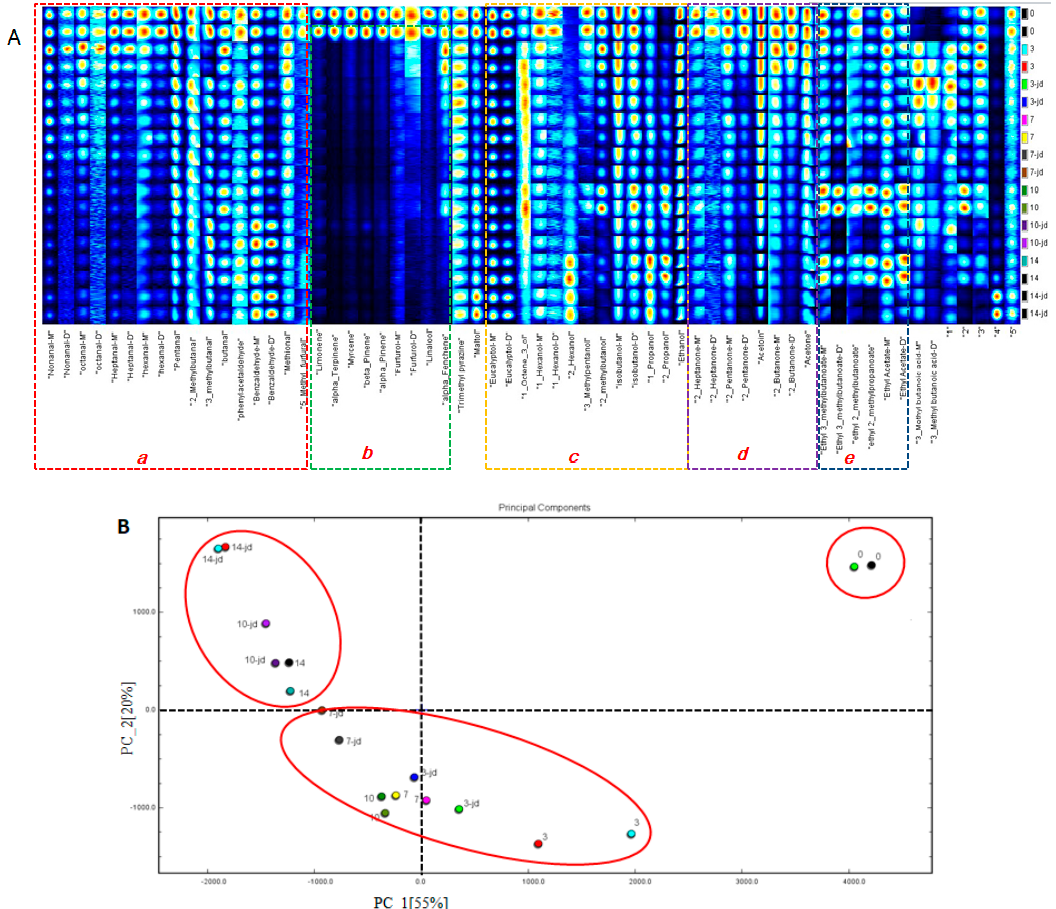
Figure 5. ( A ) The gallery plots of volatile compounds in dry-cured beef samples at 0, 3, 7, 10, and 14 days under di ff erent treatments. Each column represents the same substance in di ff erent samples, and each row represents a sample. a, red frame; b, green frame; c, yellow frame; d, purple frame; e, blue frame. ( B ) Principal component analysis (PCA) scatter diagram of volatile compounds of dry-cured beef samples.